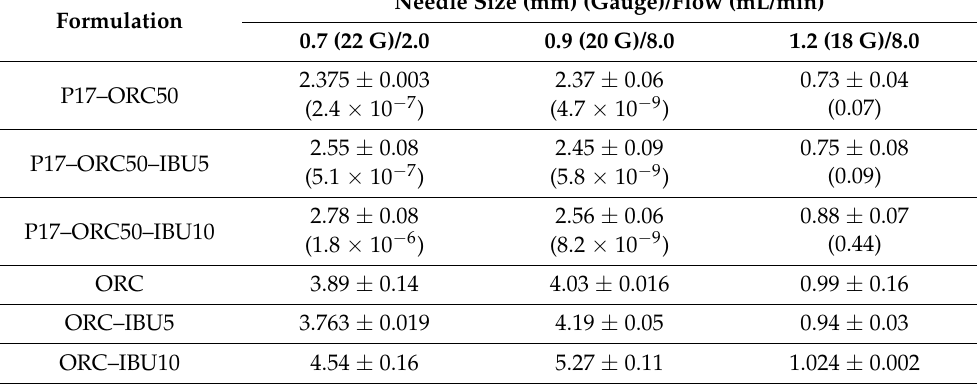
Table 5. Summary of syringeability study. Net Extrusion Forces, kg, shown as means ± sd, n = 3. Only the highest flow rates are shown for every needle size. Brackets contain the p -values obtained from post-hoc comparisons between emusions and pure ORC (in respective columns/rows). General